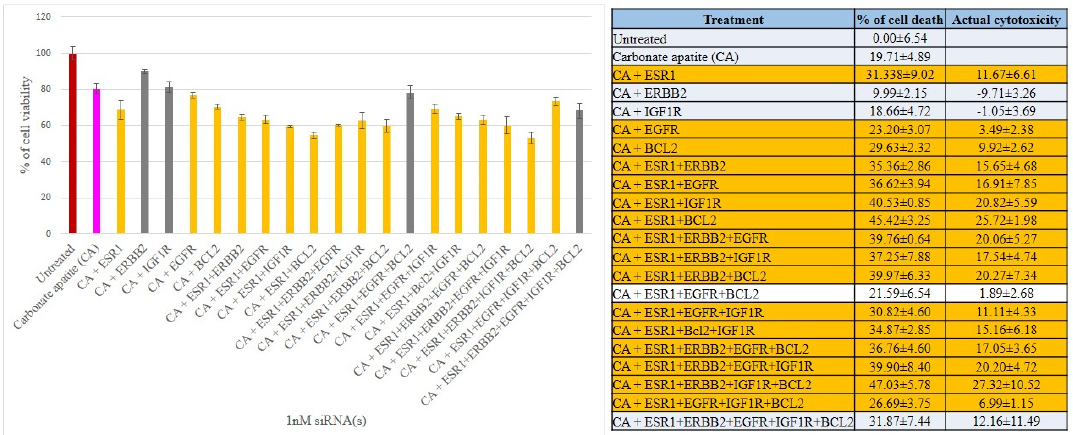
Figure 5. Cell viability and cytotoxicity assessments of 4T1 cells treated with various CA ‐ siRNA complexes involving ESR1, ERBB2, IGF1R, EGFR and BCL2 siRNAs (1 nM) individually or in combination, for a period of 48 h. Preparation of the CA ‐ siRNA(s) complexes involved introduction of ESR1, ERBB2, IGF1R, EGFR and BCL2 siRNAs individually or in combination with 3.5 mM of CaCl 2 to 1 mL of bicarbonate ‐ buffered DMEM (pH 7.4). The mixture was allowed incubation at 37 °C for 30 min before the addition of 10% FBS. The cells were incubated for the next 48 h with the prepared complexes. MTT assay was performed and absorbance reading was taken at 595 nm with 630 nm as references wavelength. Data was presented as mean ± SD of triplicates.